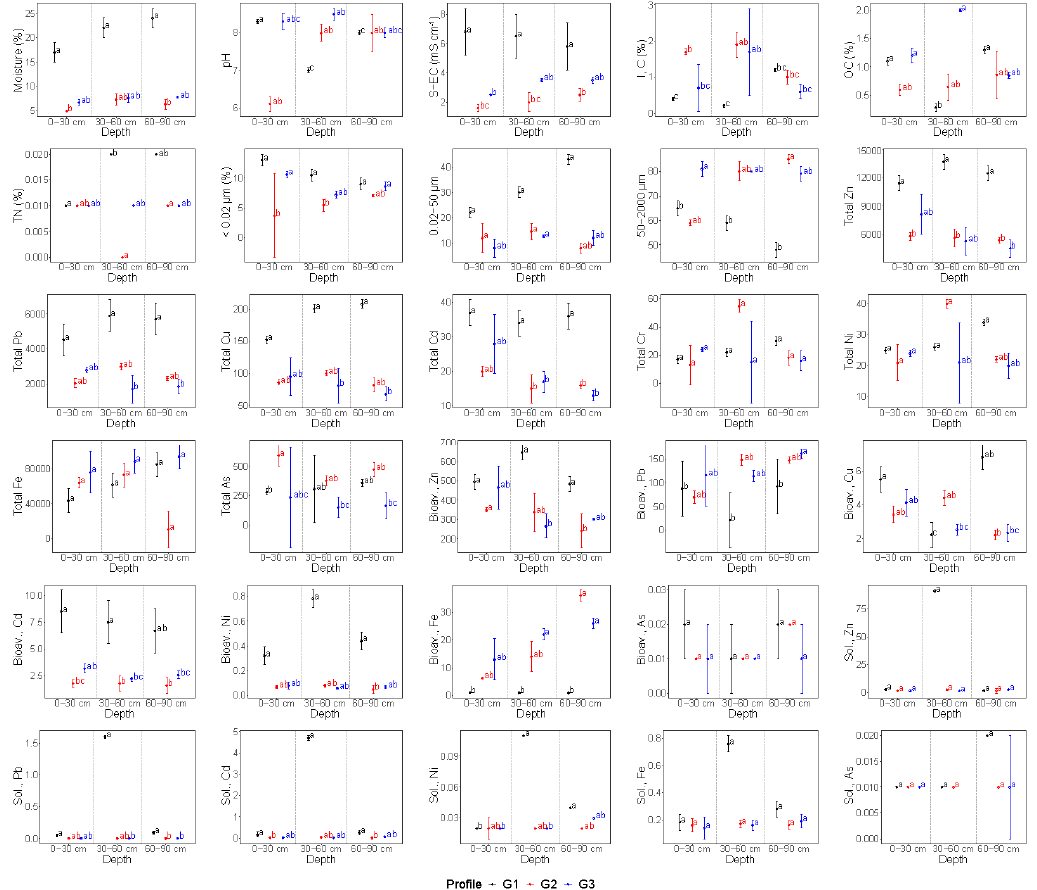
Figure 4. Soil properties, metal concentration (mg kg − 1 ) (mean ± standard deviation), and results from the Mann–Whitney U-test. Bioav.: Bioavailable; Sol.: Water soluble. Bioav. Cr, Sol. Cu, and Sol. Cr showed values lower than the detection limit of the equipment. Different letters in the same row indicate statistically significant differences between variables (P < 0.05).